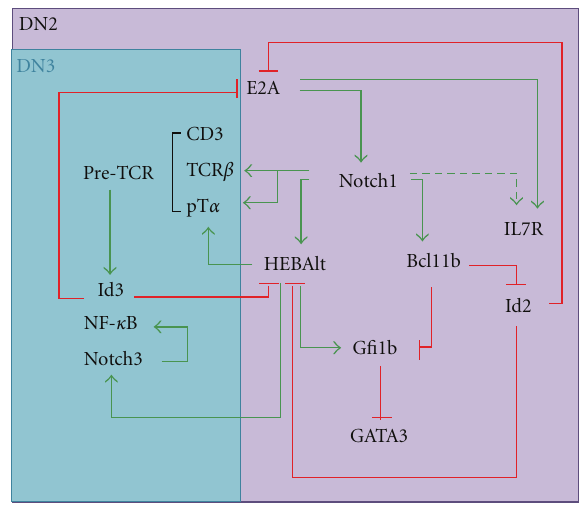
Figure 4: Gene regulatory network model operating in early T-cell development. E2A positively regulates Notch1 expression, which induces the expression of HEBAlt, Bcl11b, and IL7R. HEBAlt positively regulates T-cell genes, such as pT α and Notch3, which in turn upregulates NF- κ B signaling. Bcl11b negatively regulates Id2 and Gfi1b to balance the expression of GATA3, thus limiting the NK-cell potential. HEBAlt may also regulate GATA3 indirectly through Gfi1b. HEBAlt and Notch1 upregulate pT α and TCR β , the components of pre-TCR, thus promoting transition from the DN2 to the DN3 stage of T-cell development. Pre-TCR signaling upregulates Id3, which inhibits the activity of E2A and HEBAlt at the β -selection checkpoint. The inhibition of HEBAlt activity past the DN3 stage is important as it disrupts the positive feedback loop between Notch3 and NF- κ B, which may, otherwise, lead to leukemogenesis. Green arrows show positive inputs, red blunt arrows show negative inputs. Established connections are shown by solid arrows, and indirect or proposed connections are shown by dashed